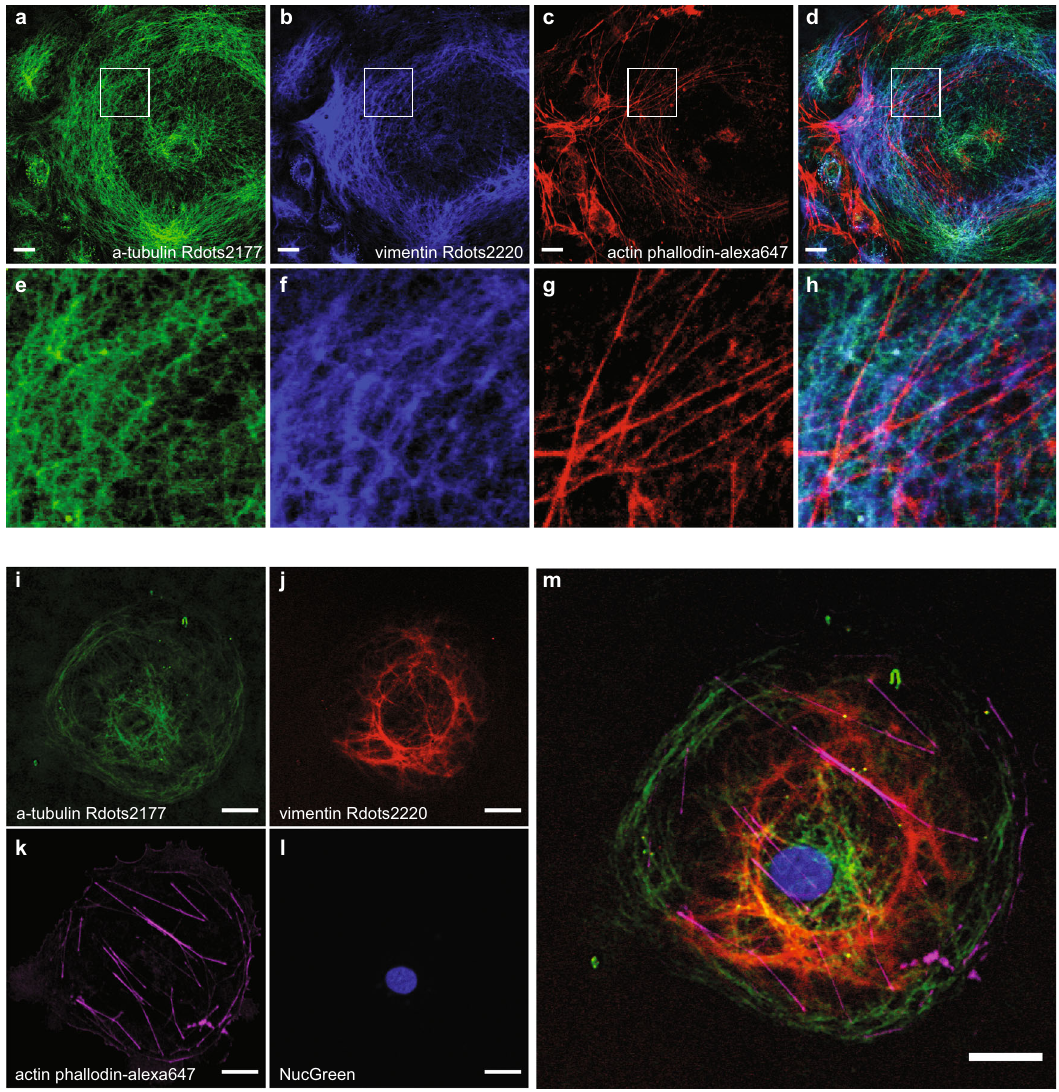
Fig. 5 Multiplexed imaging with Rdots and fl uorescence. a α -tubulin immunostaining with Rdots2177. b Vimentin immunostaining with Rdots2220. c Actin staining with phalloidin-alexa647. d Composite view of the three channels. e – h Magni fi ed view of a – d , respectively. i α -tubulin immunostaining with Rdots2177. j Vimentin immunostaining with Rdots2220. k Actin staining with phalloidin-alexa647. l DNA staining with NucGreen. m Composite view of the four channels. Scale bar: 20